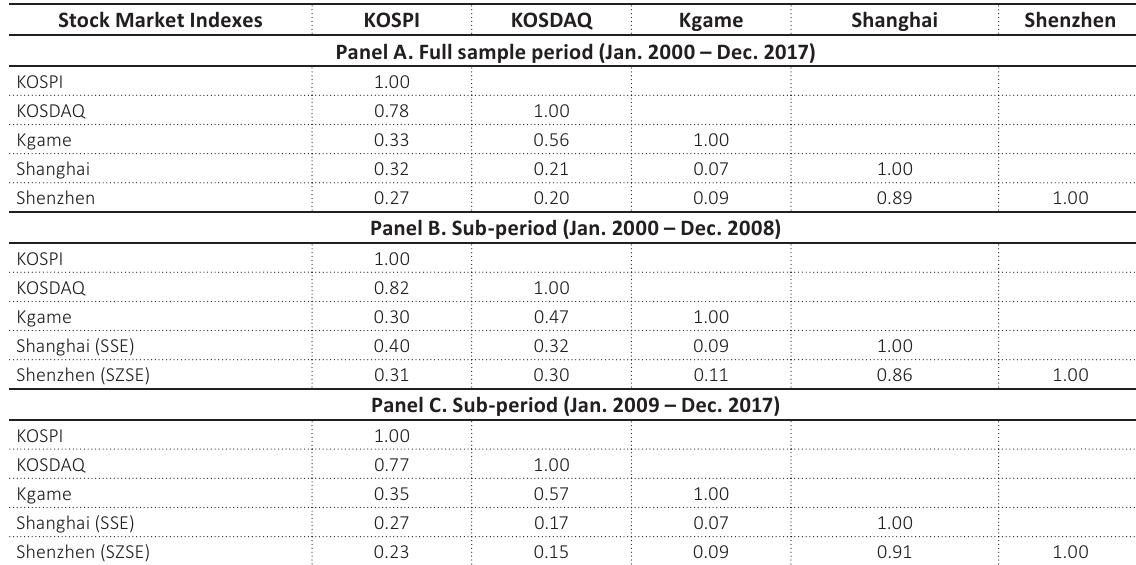
full sample period. Panels B and C display the re- sults for two sub-periods. From the Engle-Granger cointegration test, all the coefficients of γ in Table 6 range from –0.82 to –1.34, and the absolute val- ues of all the t-statistics are greater than 2.00. The null hypothesis of no cointegration is rejected, with 95 percent confidence.